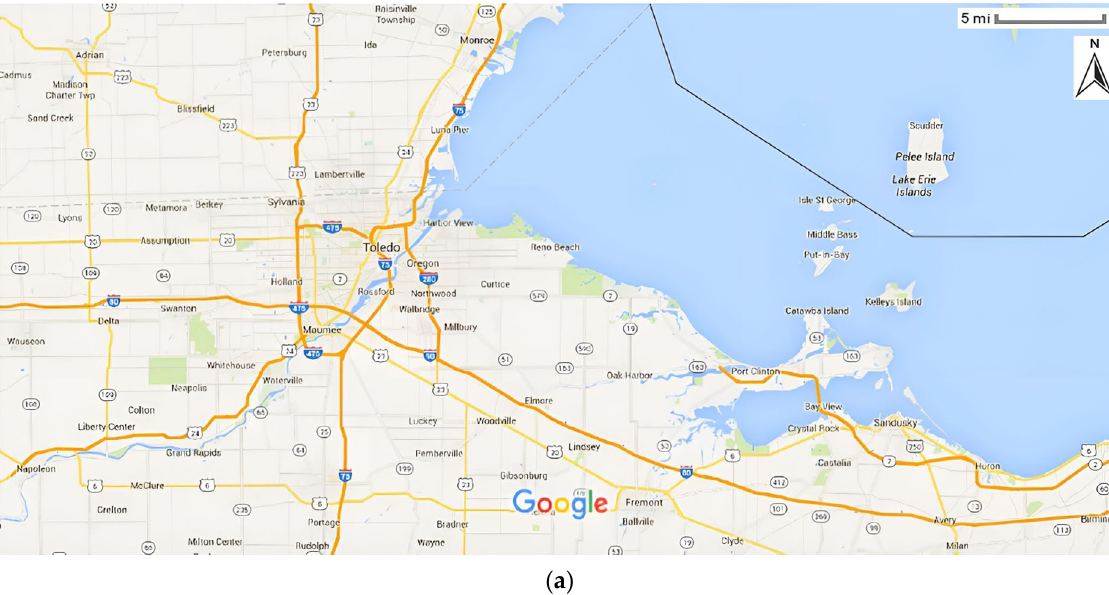
( b ) Figure 3. ( a ) Water body and watershed polygons. ( b ) The layout of existing and proposed plant locations. 2.8. Estimating Media Concentrations In this study, a portion of the receptor diet is assumed to consist of produce that is either below ground or aboveground, protected or unprotected. The sum of the contami ‐ nation resulting from the above three mechanisms was used to estimate the concentration of COPCs in aboveground and unprotected produce. The concentration of aboveground produce due to direct deposition ( Pd ) in mg of COPC per kg of DW is estimated by using Equation (1).